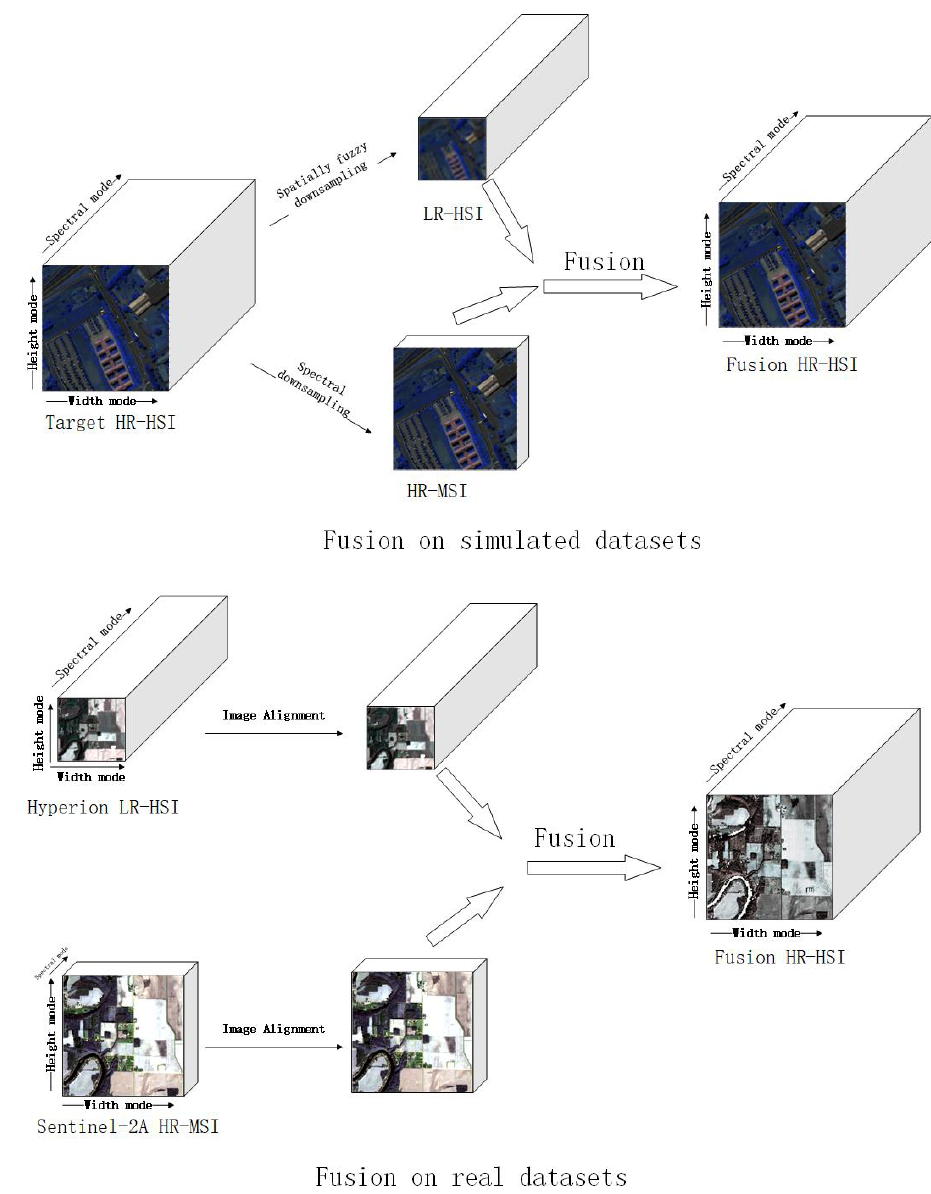
Figure 1. Flowchart for achieving super-resolution using a fusion